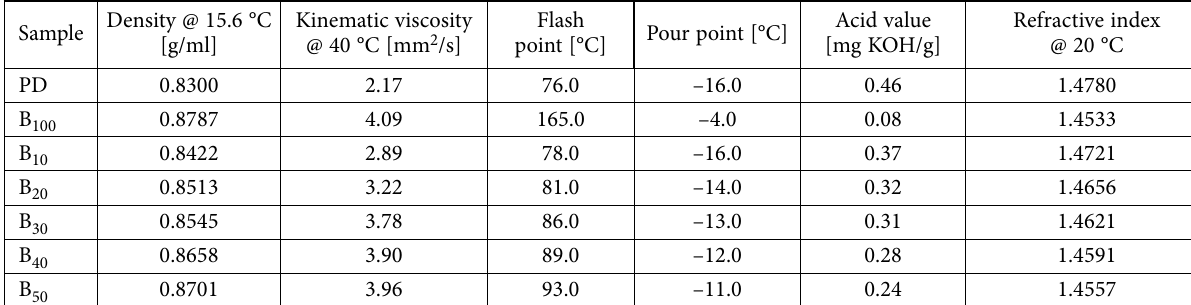
Table 4. Properties of (BD + PD) blends